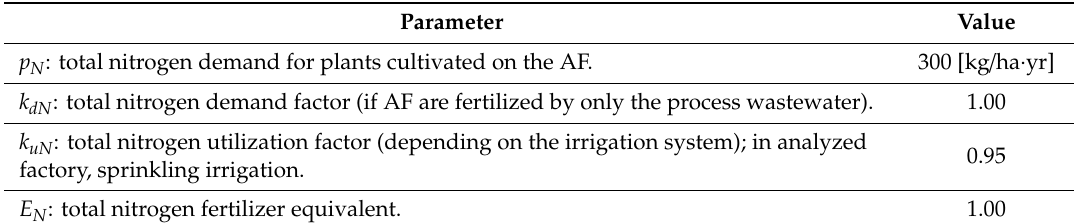
Table 3. Data for plants cultivated in the